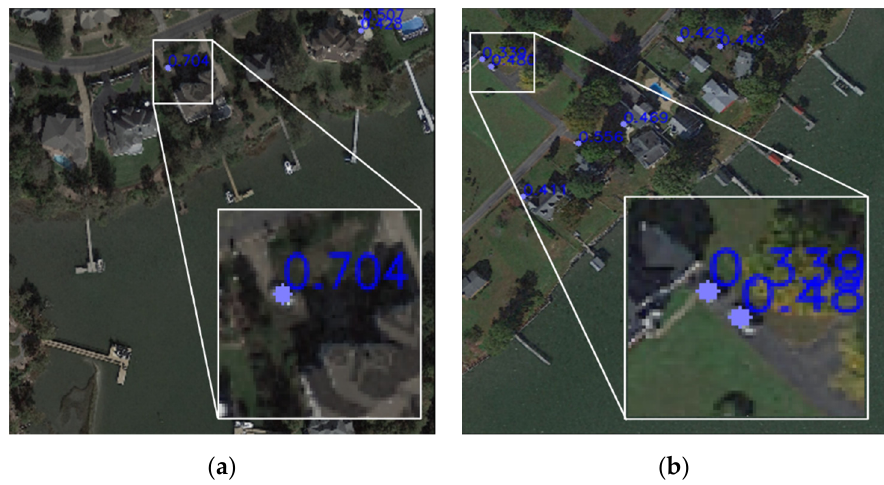
Figure 8. Examples of enlarged images of some smaller objects. The object occupies about 3 × 7 pixels. ( a ) Example 1, ( b ) Example 2.